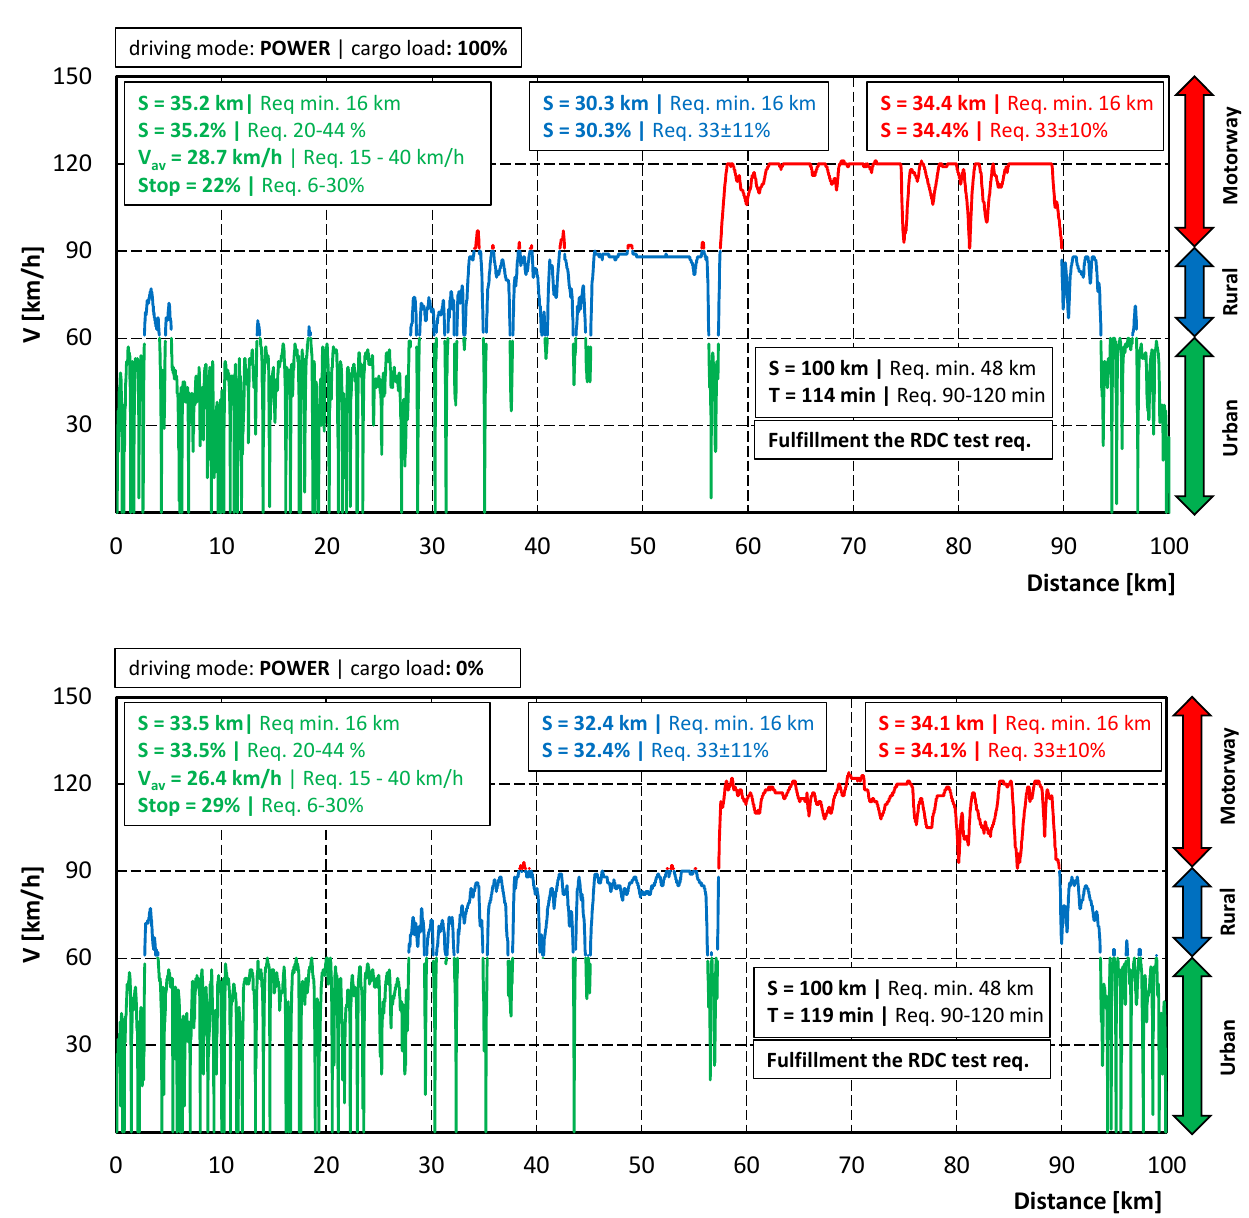
Figure 16. The course of RDC test in different driving mode with defining basic parameters for meeting test